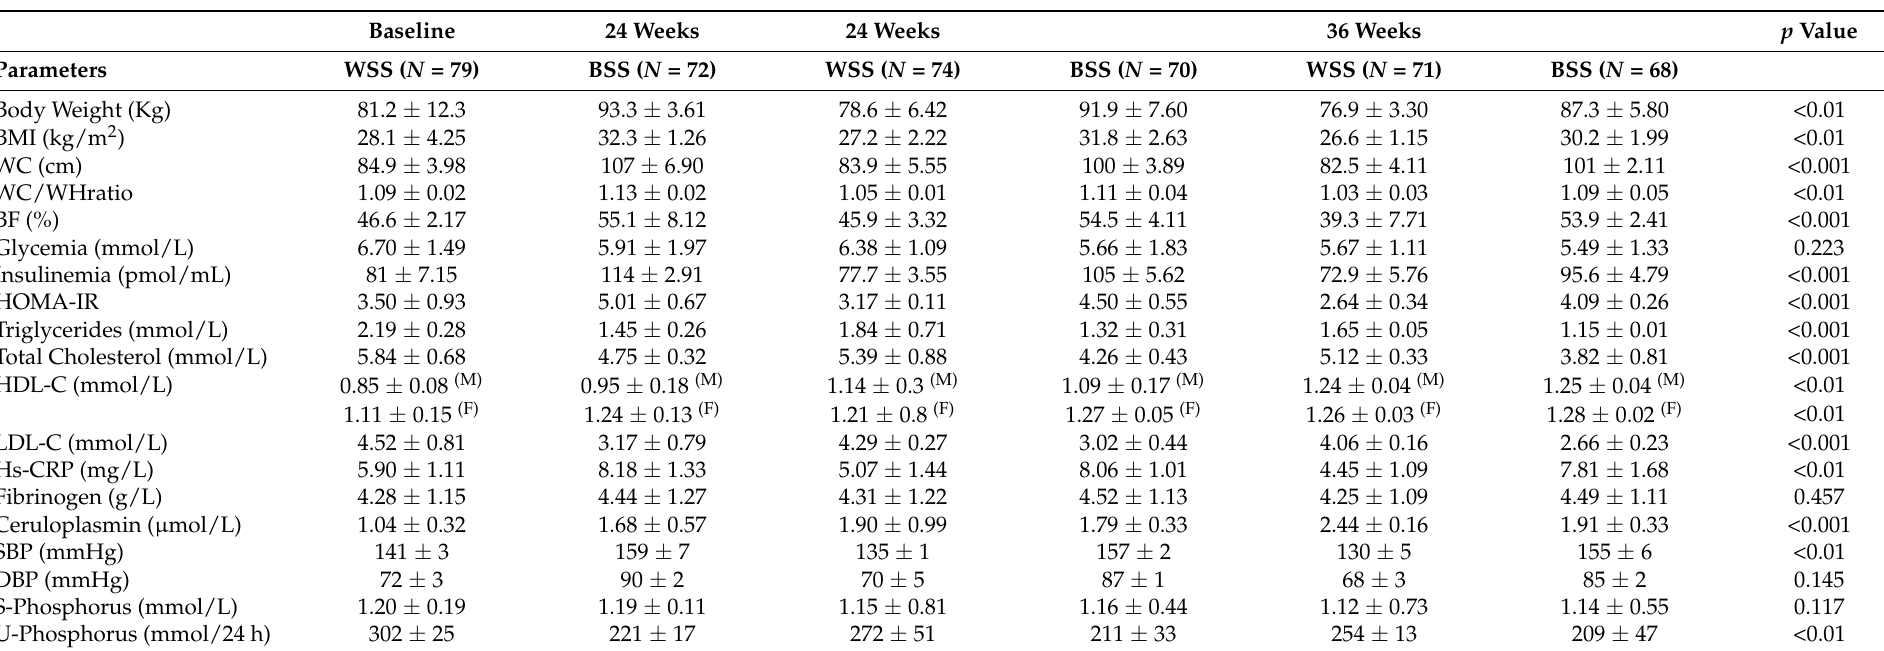
Table 2. Effects of oral 2000 IU vitamin D3 supplementation/day at 24 and 36 weeks on the MetS clusters in Blacks versus Whites SS CKD